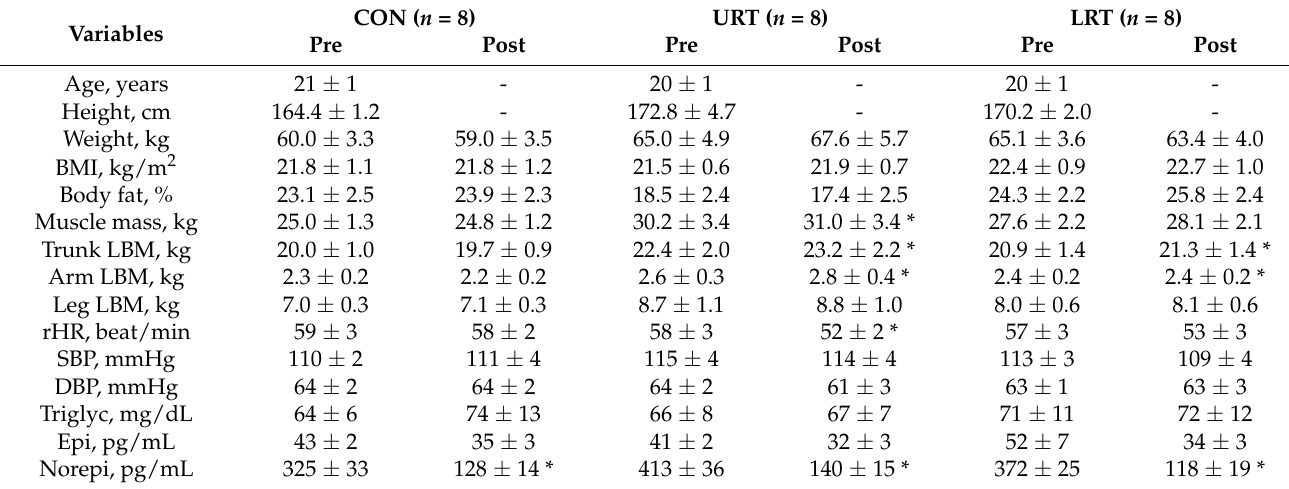
Table 1. Participant characteristics pre- and